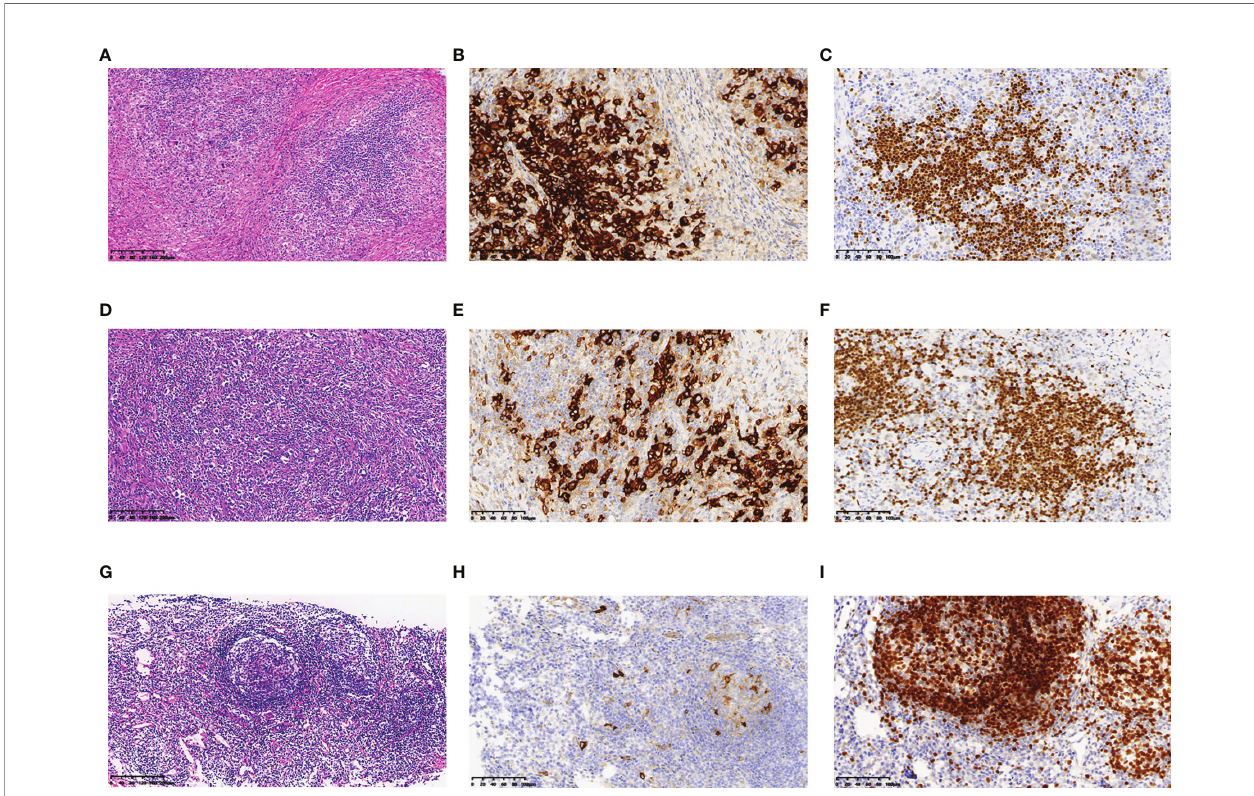
FIGURE 1 | Histopathology and immunohistochemistry of the lymph nodes of this patient. In October 2019, (A) HE staining revealed nodular sclerosis classic Hodgkin lymphoma (10×), IHC staining showed that lymphoma cells were positive for (B) CD30 (20×), (C) PAX-5 (20×). In May 2020, (D) HE staining revealed nodular sclerosis classic Hodgkin lymphoma (10×), IHC staining showed that lymphoma cells were positive for (E) CD30 (20×), (F) PAX-5 (20×). In December 2020, (G) HE staining revealed lymphoid tissue had a proliferative change (10×), IHC staining showed that lymphoma cells were negative for (H) CD30 (20×), and positive for (I) PAX-5